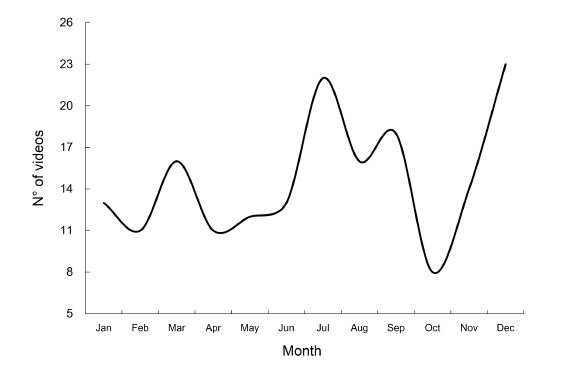
Fig. 3 . Number of videos of hunting events posted on YouTube™ per month.